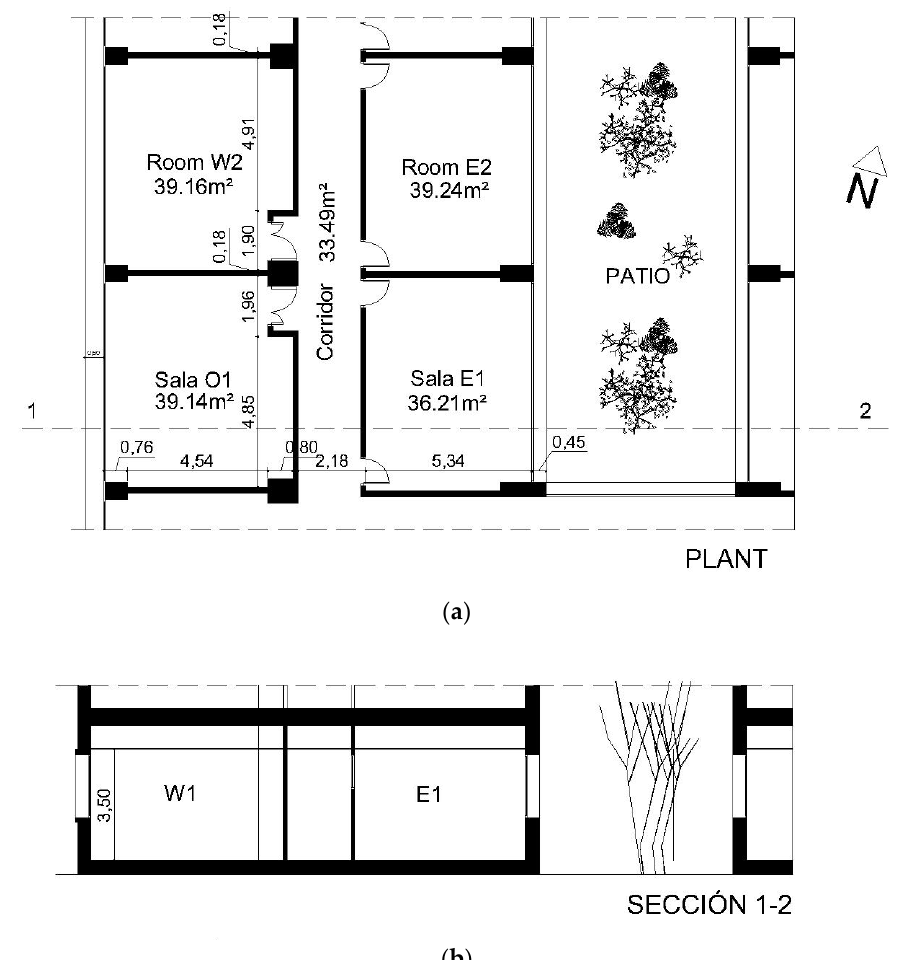
Figure 5. General plans of the block of five thermal zones under study: ( a ) layout of the ground floor; and ( b ) sectional view.